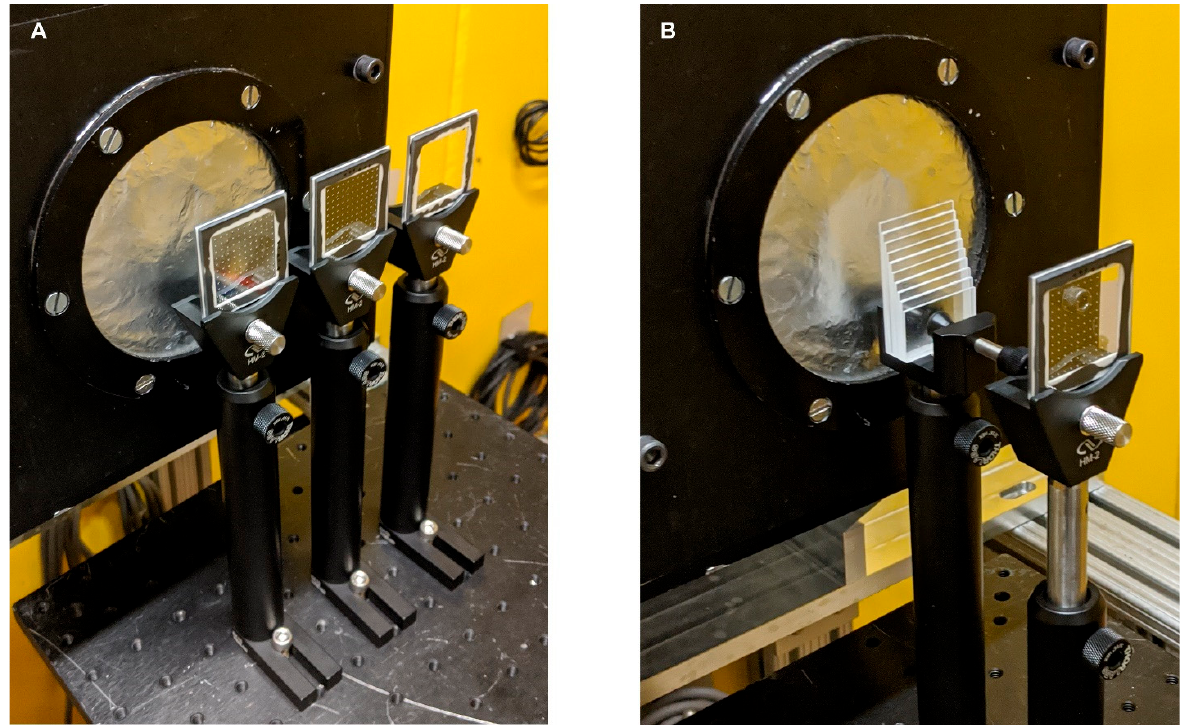
Figure 5. NCNR BT2 setup. ( A ) BB grids placed in optical holders in front of neutron detector. ( B ) PMMA step wedge between BB grid and detector.